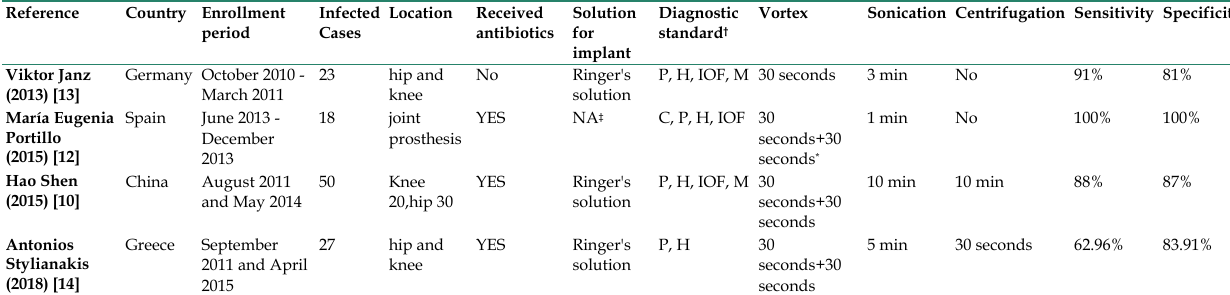
Figure 2. Methodological quality summary Table 1. The detail characteristics of the included studies